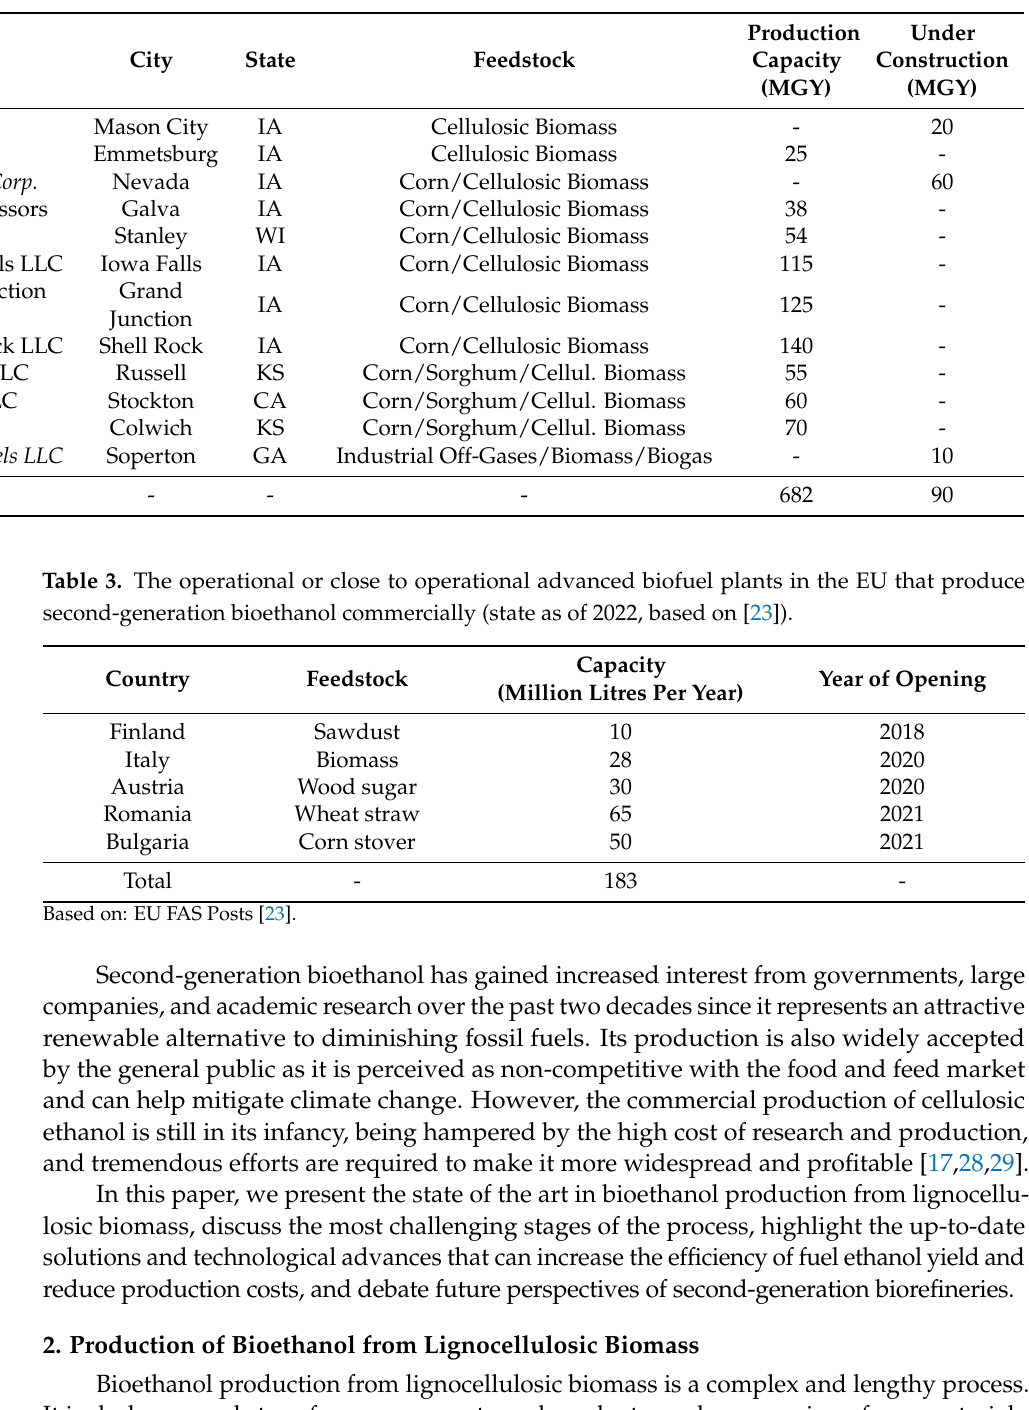
Table 2. Second-generation or mixed biorefineries in the US (state as of 2022) [27]; MGY–million gallons per year; biorefineries under construction are in italics.